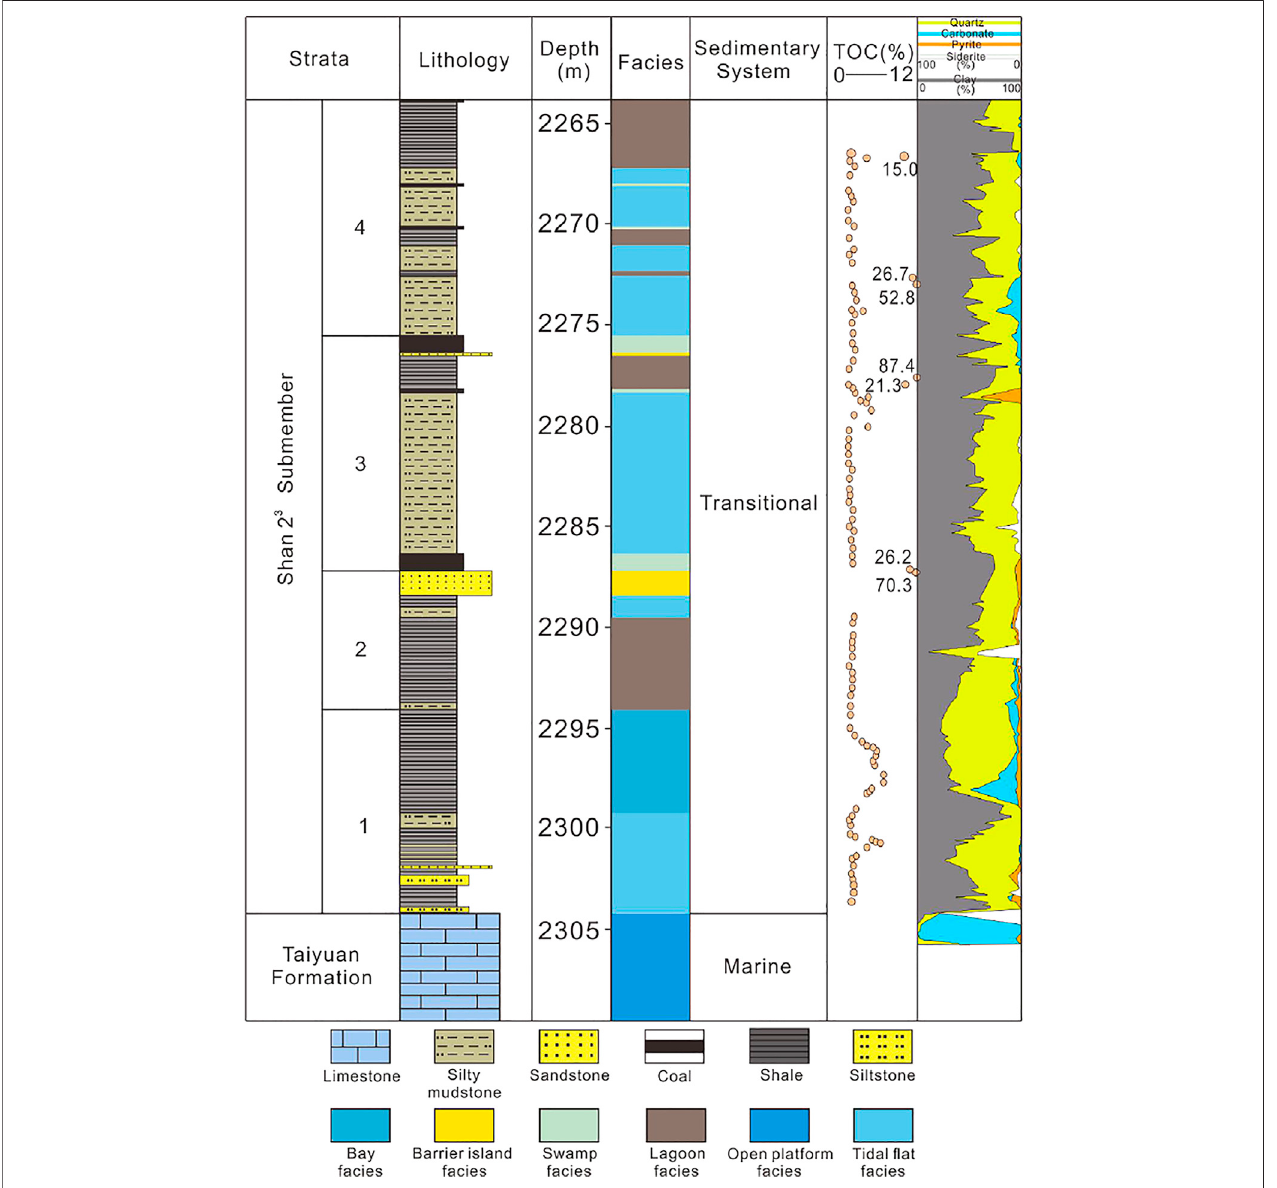
FIGURE 4 | Stratigraphic column and vertical distribution of TOC content and sedimentary environment of the Shanxi Formation Shan 2 3 Submember shale from the studied well in Eastern Ordos.